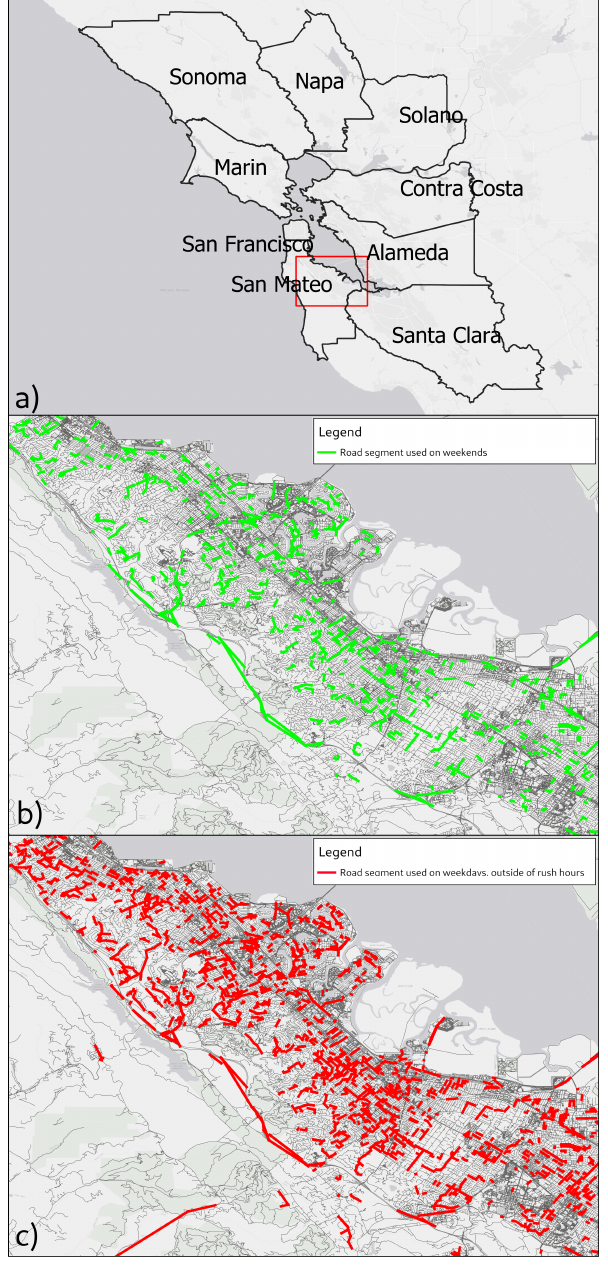
Figure 5. Comparison of road segment use for different temporal subsets of the Twitter data. Map ( a ) shows the location of the detailed maps within the study area. Maps ( b , c ) show the road segment usage for different temporal